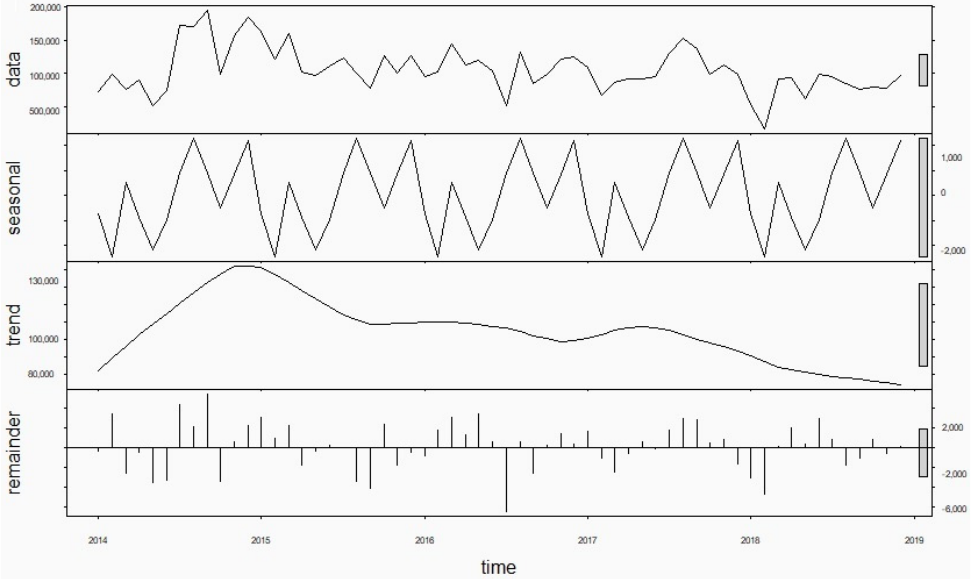
Figure 7. Components of trend and seasonality.